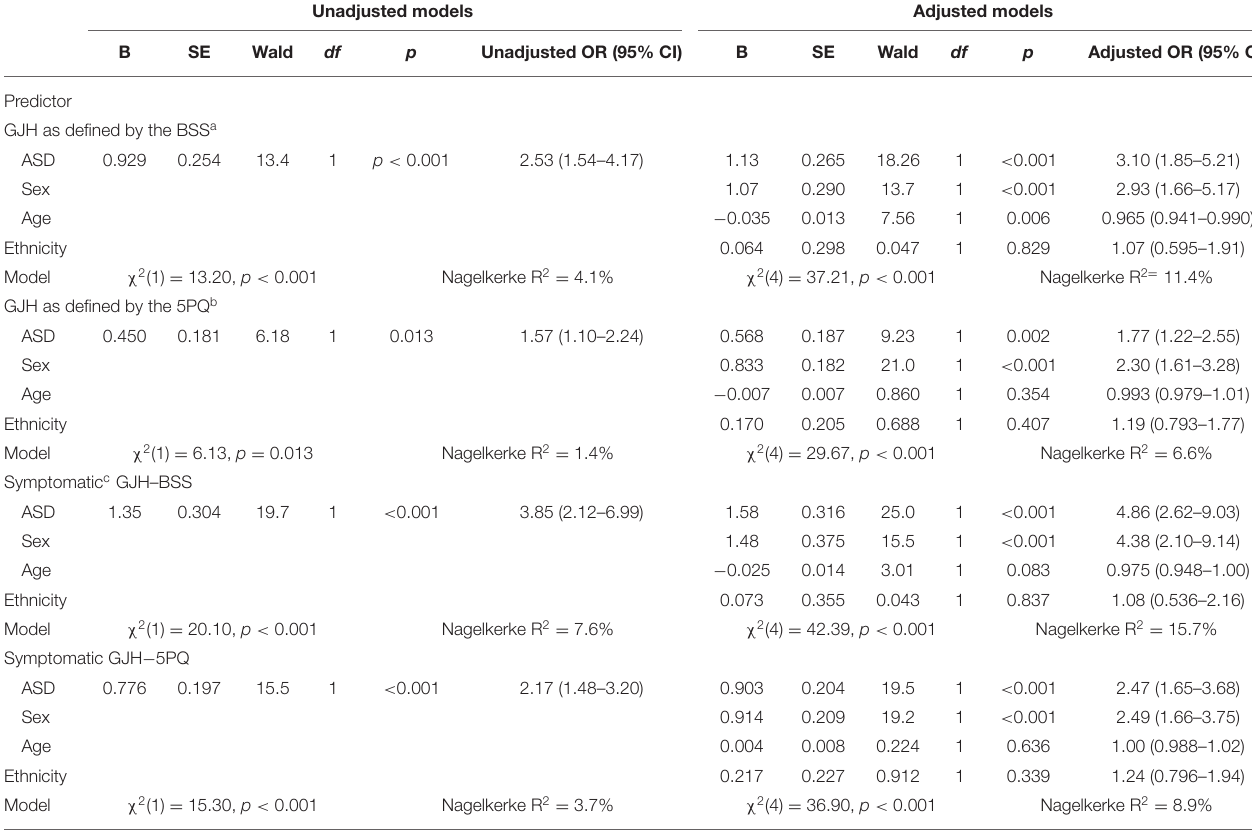
TABLE 3 | Results of the logistic regression models on ASD diagnosis relationshi p with generalised joint hypermobility. Unadjusted models Adjusted